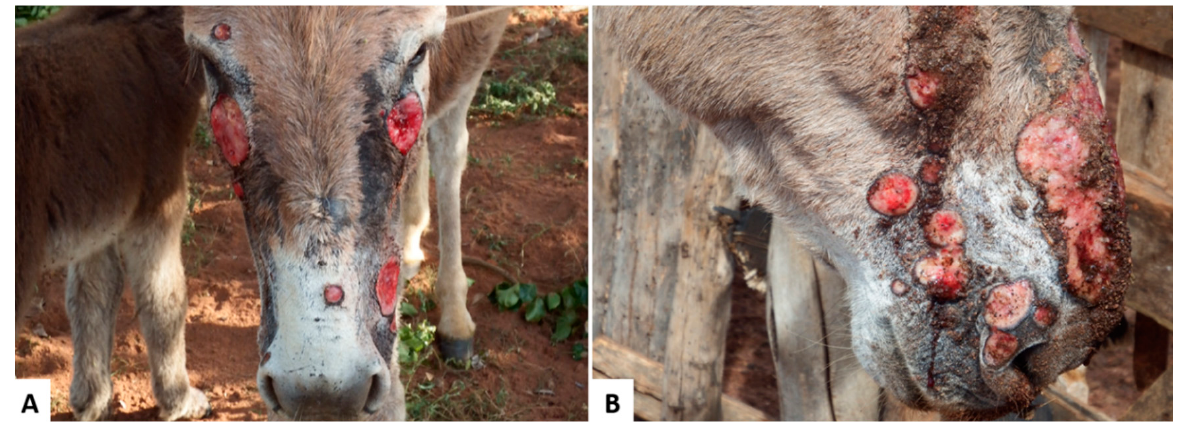
Figure 1. Donkeys naturally poisoned by Froelichia humboldtiana . ( A ) Multiple skin ulcers caused by secondary self-mutilation to intense itching; ( B ) Multiple and extensive ulcerated wounds, that drained serous exudate.